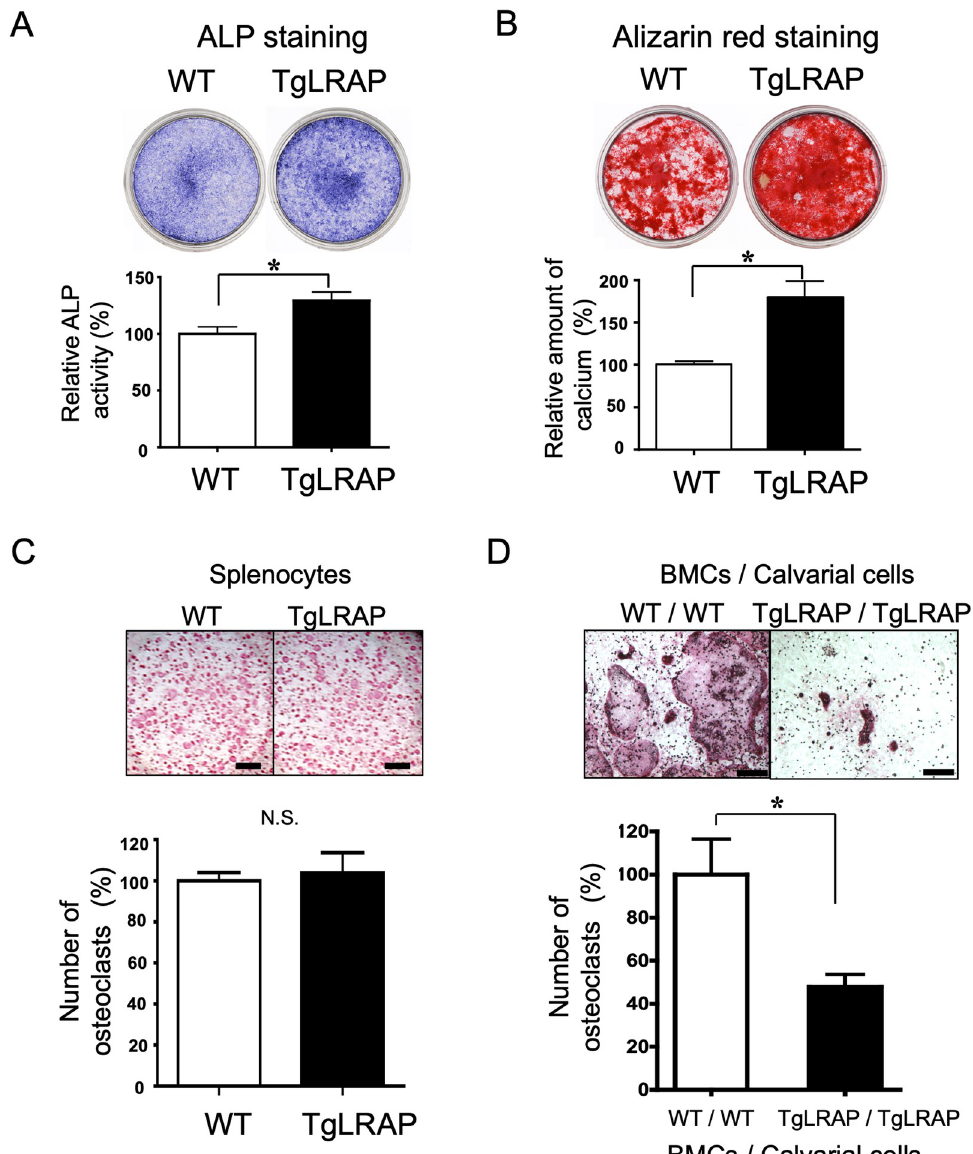
Fig 3. Increased osteoblastic activity and decreased osteoclastogenesis in TgLRAP cells in vitro . A and B, Representative examples of ALP and alizarin red staining of osteoblastic cells isolated from calvaria bones. The experiments were repeated 3 times. Relative ALP activities ( A , at day 10) and accumulated calcium amount ( B , at day 21) were statistically higher in the TgLRAP cells as compared to the WT (graphs). C, TRAP staining of spleen cells cultured with RANKL and M-CSF. The numbers of osteoclasts (TRAP positive cells) were compared at 9 days of culture. No differences were found between WT and TgLRAP. Bars = 1 mm. D, TRAP staining of co-cultured BMCs and calvarial cells at 7 days of osteoclast induction. Compared with the co-culture of WT BMCs and WT calvarial cells (WT / WT), the number of osteoclasts were significantly decreased at 50% in the co-cultures of TgLRAP BMCs and TgLRAP calvarial cells (TgLRAP / TgLRAP) (graph). Bars = 500 μ m. The experiments were repeated 3 times. Each column represents the mean ± SD. � p < 0.05. WT; wild-type mouse, TgLRAP; LRAP transgenic mouse. with TgLRAP calvarial cells (Fig 3D; TgLRAP / TgLRAP). These results suggested the inhibi- tory effects of calvarial and bone marrow mesenchymal cells obtained from TgLRAP mice on the osteoclastogenesis in vitro .